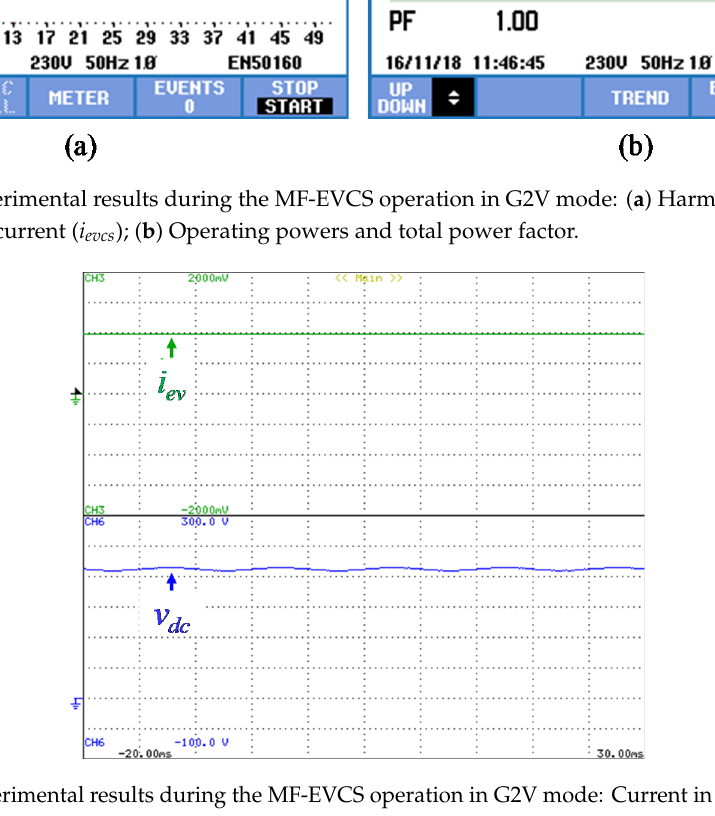
Figure 5. Experimental results during the MF-EVCS operation in G2V mode: Current in the EV battery ( i ev : 2 A/div) and dc-link voltage ( v dc : 50 V/div).